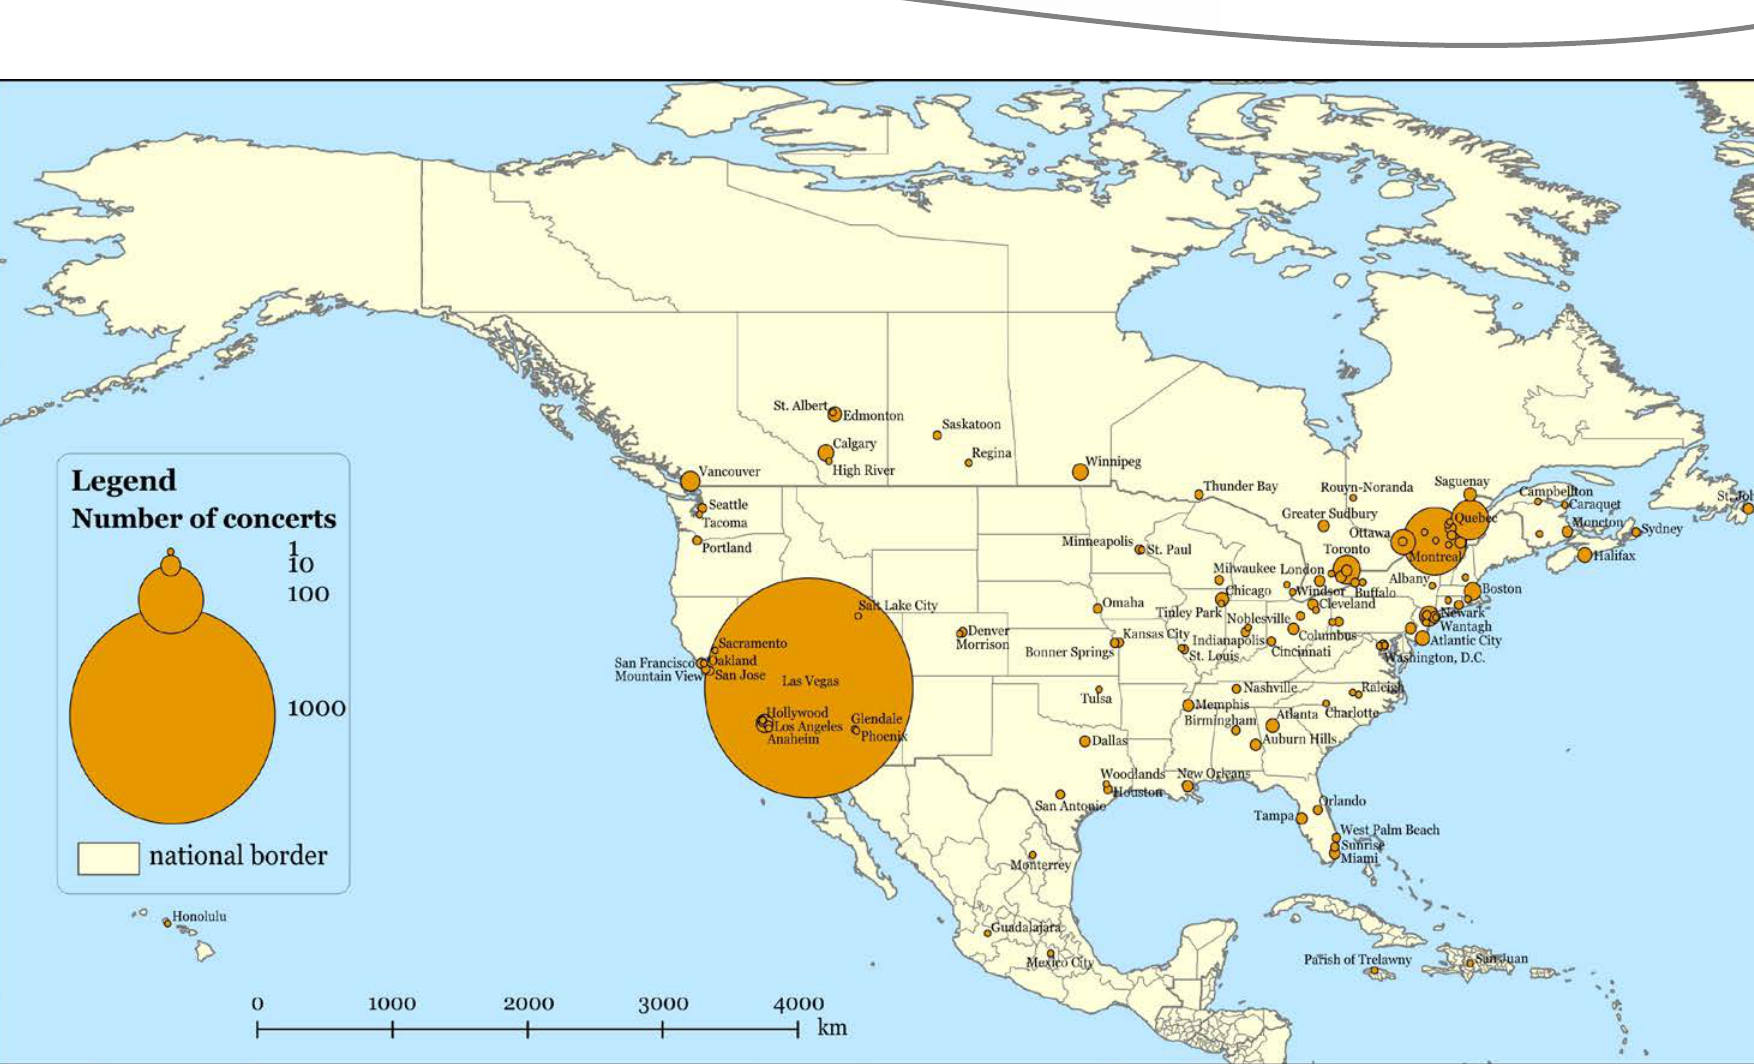
Figure 6: American cities as music scenes where Dion performed (1984 –